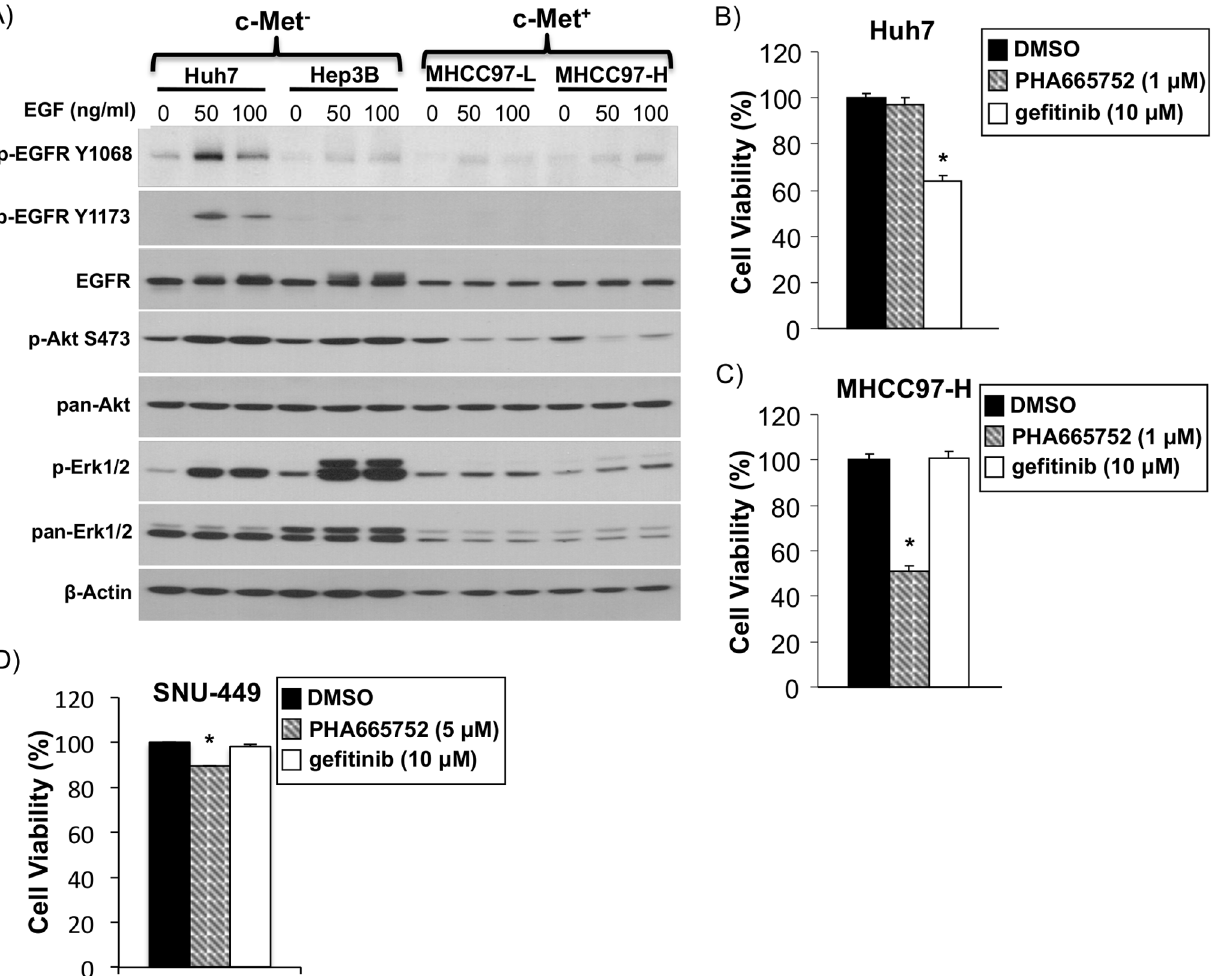
Fig 2. EGFR is a compensatory, not concomitant survival pathway in c-Met + HCC. A) Immunoblot of c-Met - cell lines Huh7 and Hep3B and c-Met + cell lines MHCC97-L and MHCC97-H 24 hours post EGF treatment (0, 50, or 100 ng/ml) for EGFR, Akt and Erk signaling pathway activation. B) XTT cell